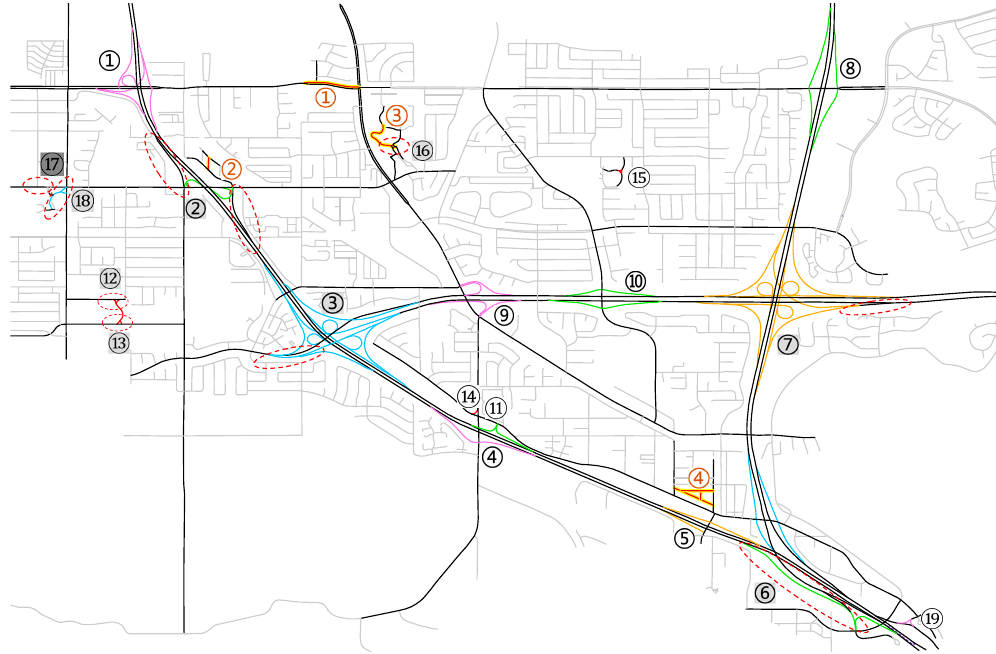
Figure 15. The identification result obtained from the input with errors. The nineteen labels of the complex junctions to be identified are in three grey levels. White stands for exact identification, light grey for various degree of inexactness, and dark grey for misses. For those inexactly identified or missed, red dashed ellipses are used to circle the extents of concern. The four artefact complex junctions that were mistakenly identified are highlighted and labeled with the red